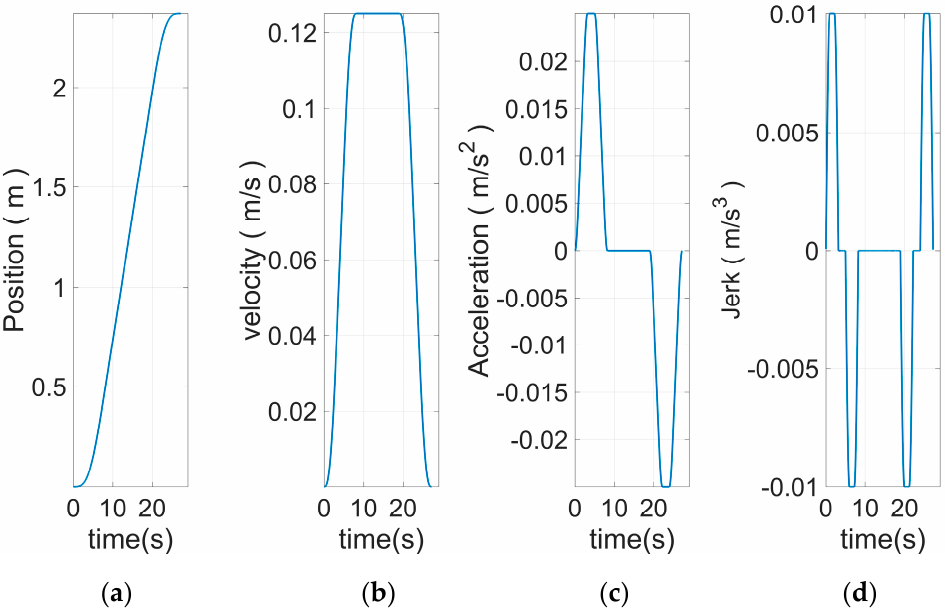
Figure 10. ( a ) Displacement of the spatial trajectory over time. ( b ) Velocity of the spatial trajectory over time. ( c ) Acceleration of the spatial trajectory over time. ( d ) Jerk of the spatial trajectory over time.